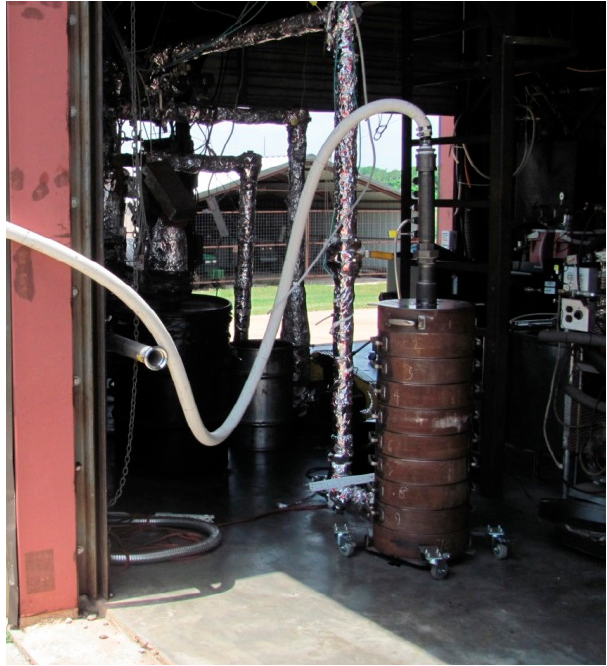
Figure 1. Schematic diagram of the three gas cleaning treatments: ( I ) wood shavings filter; ( II ) heat exchanger + wood shavings filter; and ( III ) oil bubbler + wood shavings filter. Table 2. Gasifier operating conditions.